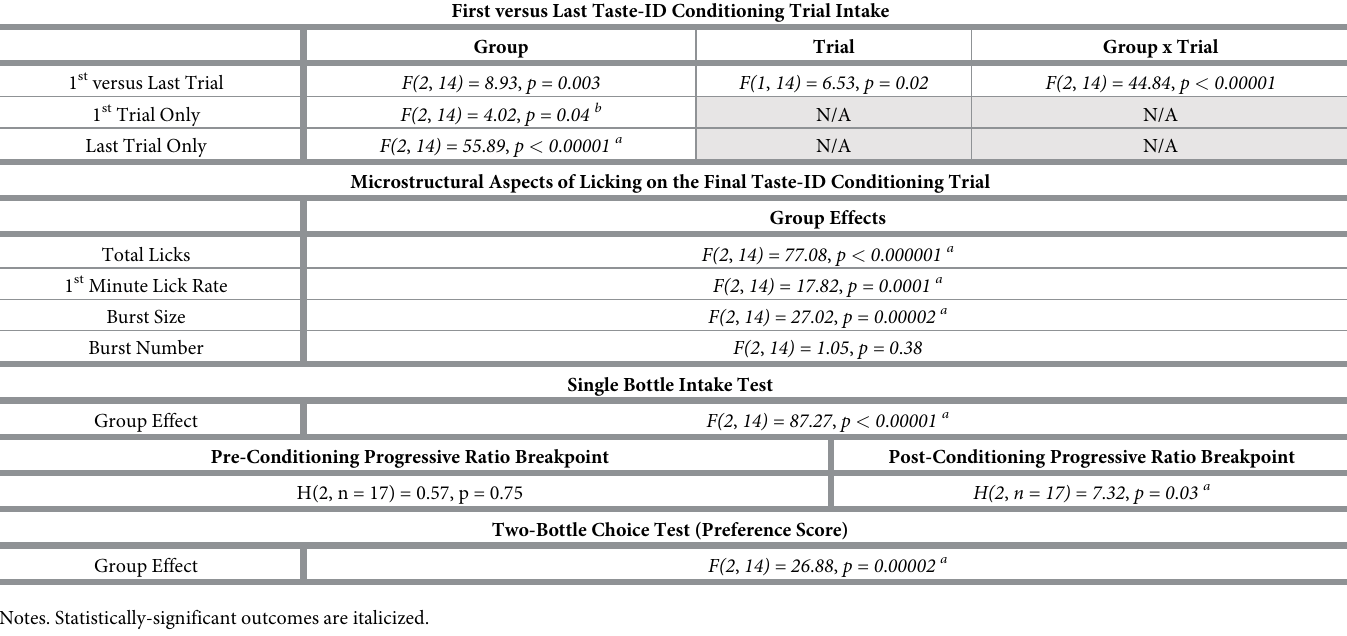
Table 2. Statistical outcomes for Experiment 2.